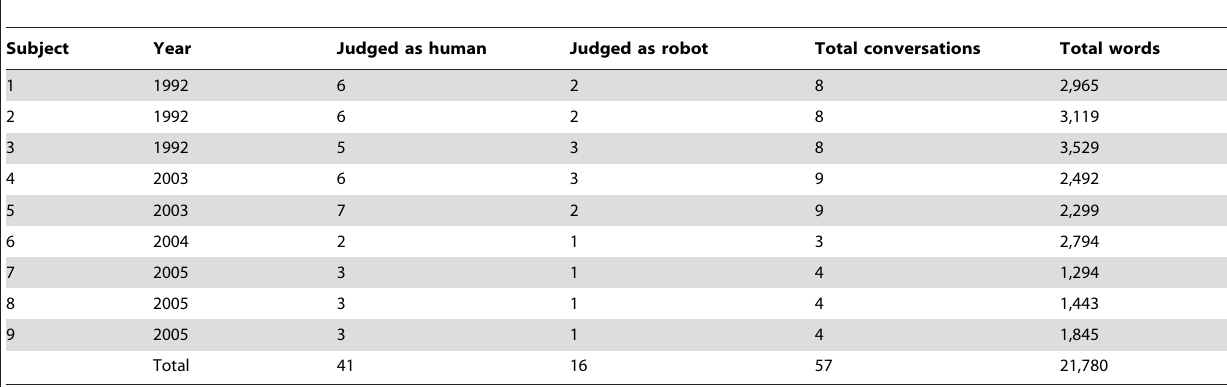
Table 1. Description of the